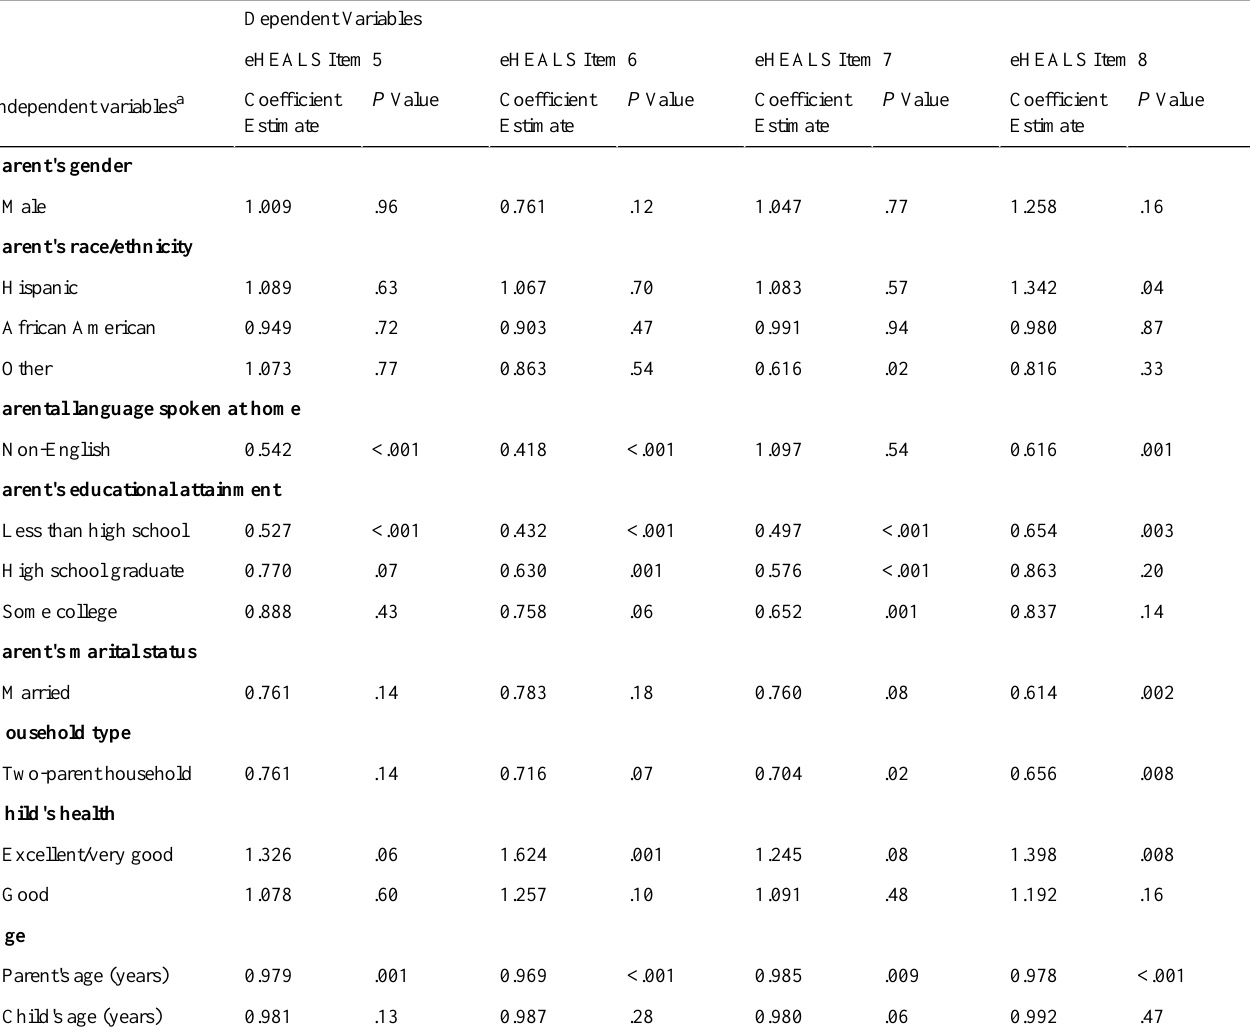
Table 6. Multivariate ordered logit regressions (eHEALS items 5 through 8) Dependent